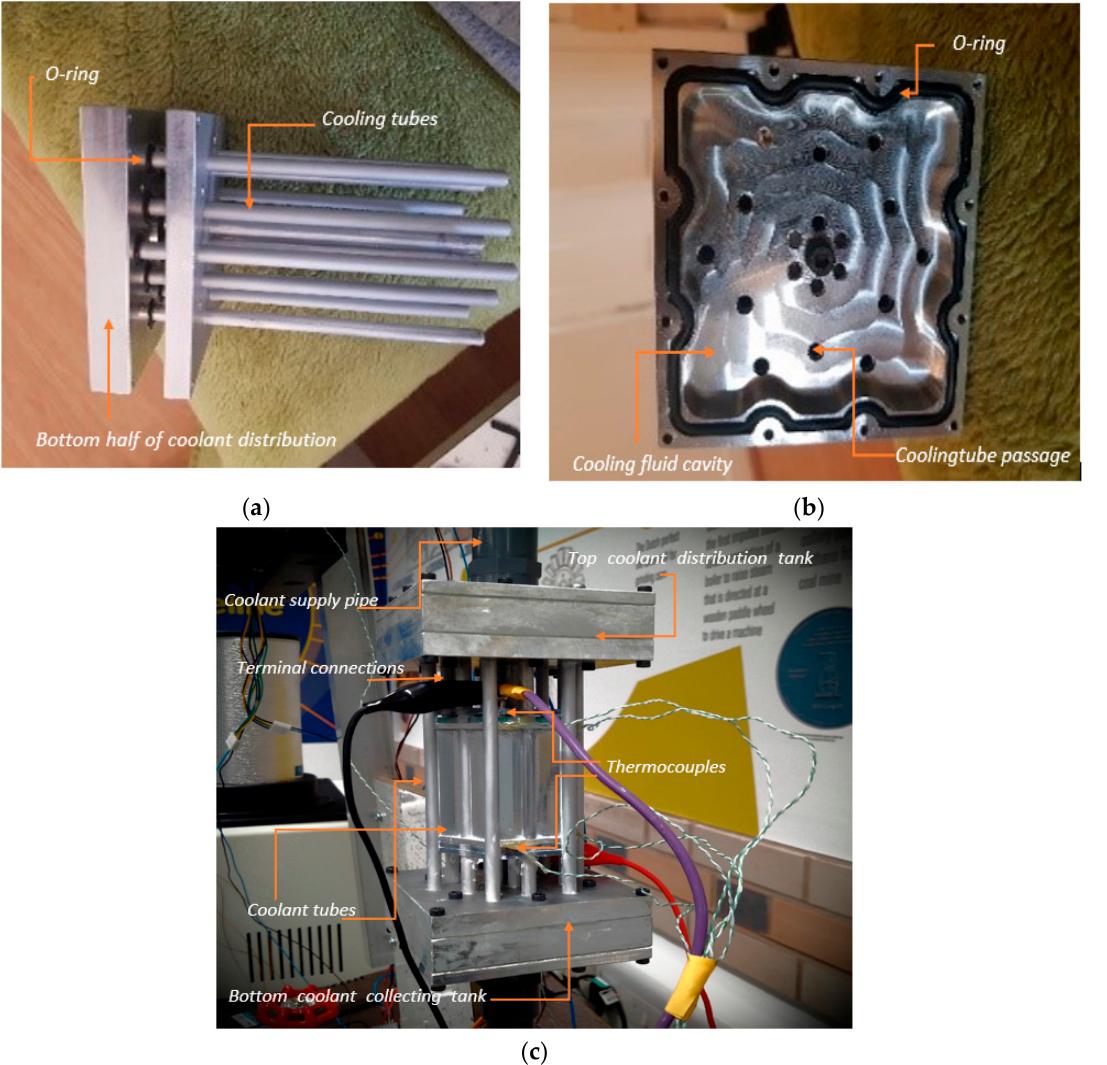
Figure 8. ( a ) The bottom half, ( b ) the top half, and ( c ) the fully assembled module test setup of coolant collection tank, including temperature measurement and electrical